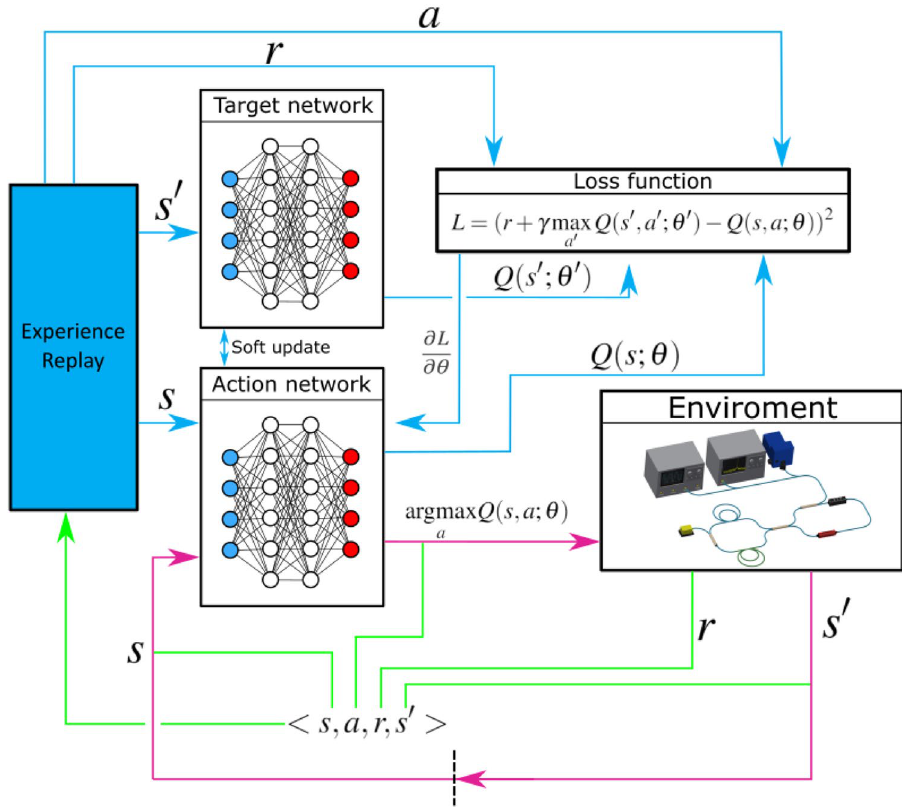
Figure 6. The architecture of double deep Q-learning network with experience replay buffer. Purple arrows show the agent’s interaction with the environment. The dotted line separates the time steps. Green lines show what is saved in the experience replay buffer and at what stages. Blue arrows describe the agent training